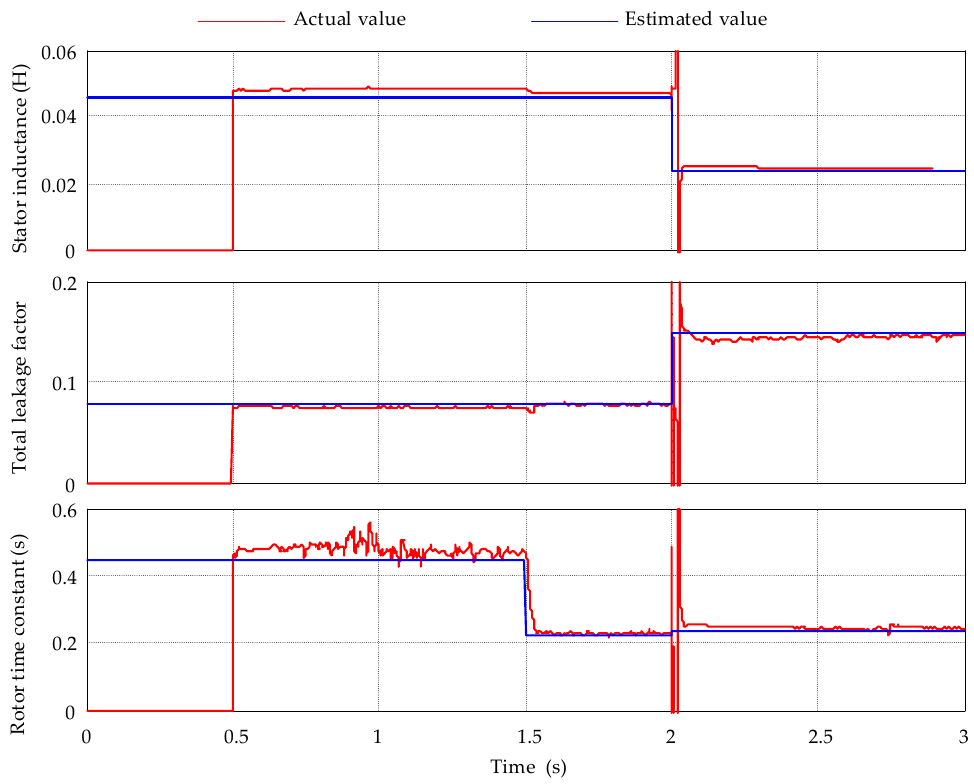
Figure 12. Identification results of the IM using the online recursive least square algorithm, where the rotor resistance and magnetizing inductance were changed at t = 1.5 s and 2 s, respectively. Table 4. Identification values of the IM using the online RLS algorithm at steady state.